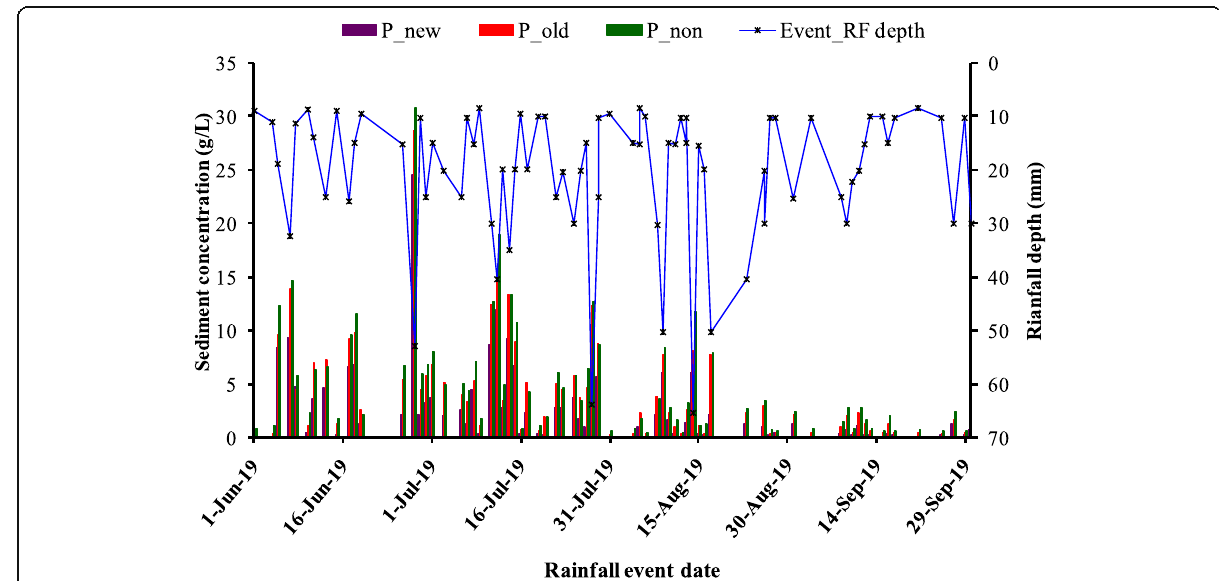
Fig. 5 Event-based rainfall depth ( RF , in millimeters) and sediment concentration ( SC , in g L − 1 ) were observed in the new- and old-graded soil bund-treated and non-treated